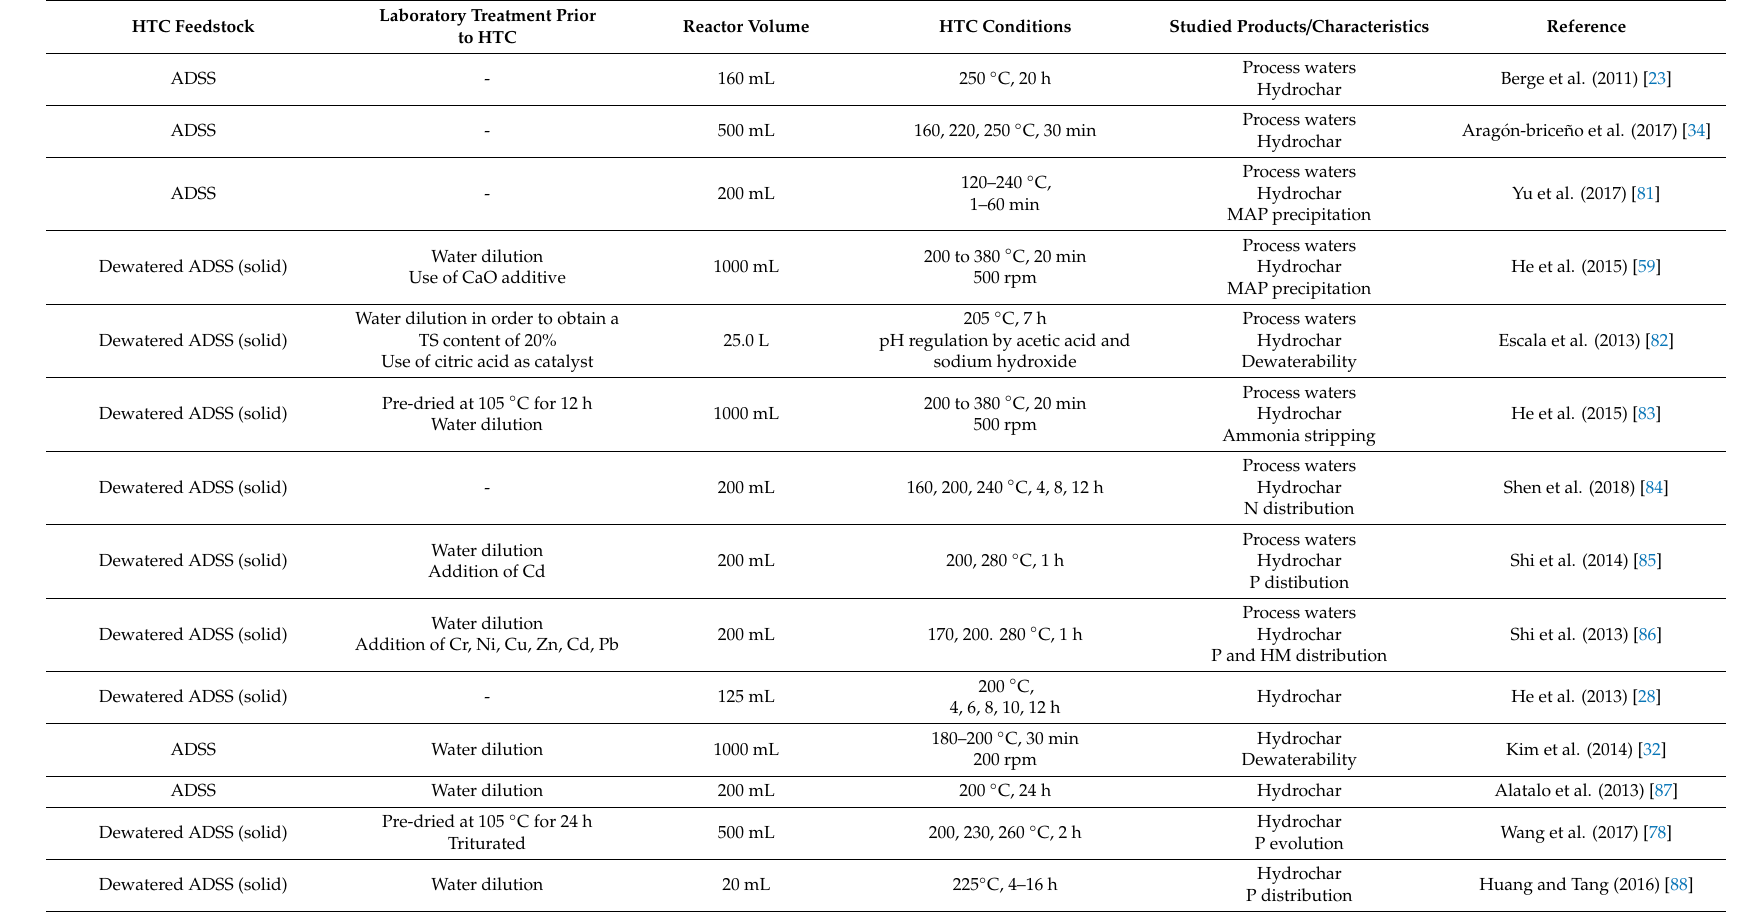
Table 2. Hydrothermal carbonization (HTC) process applied to